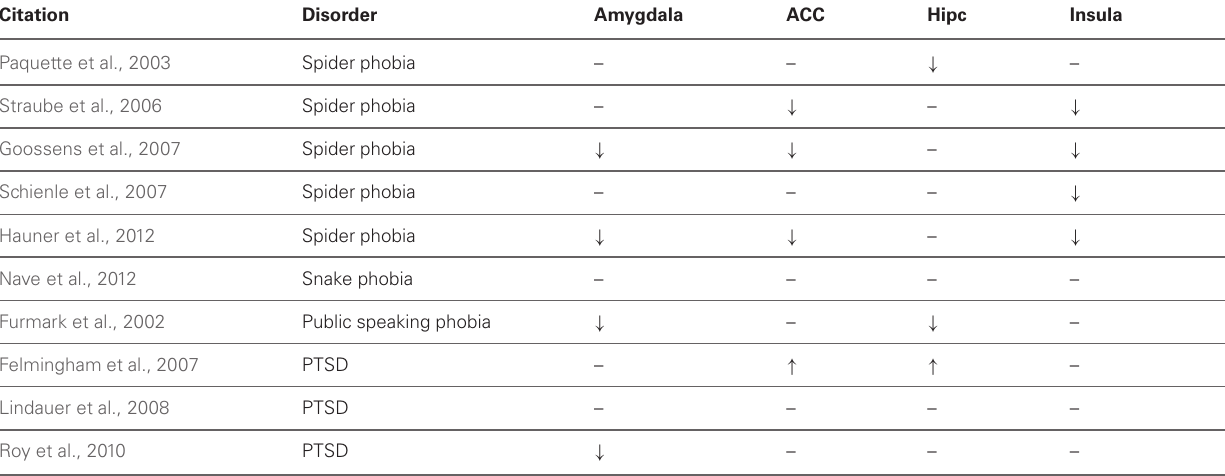
Table 2 | Summary of functional brain